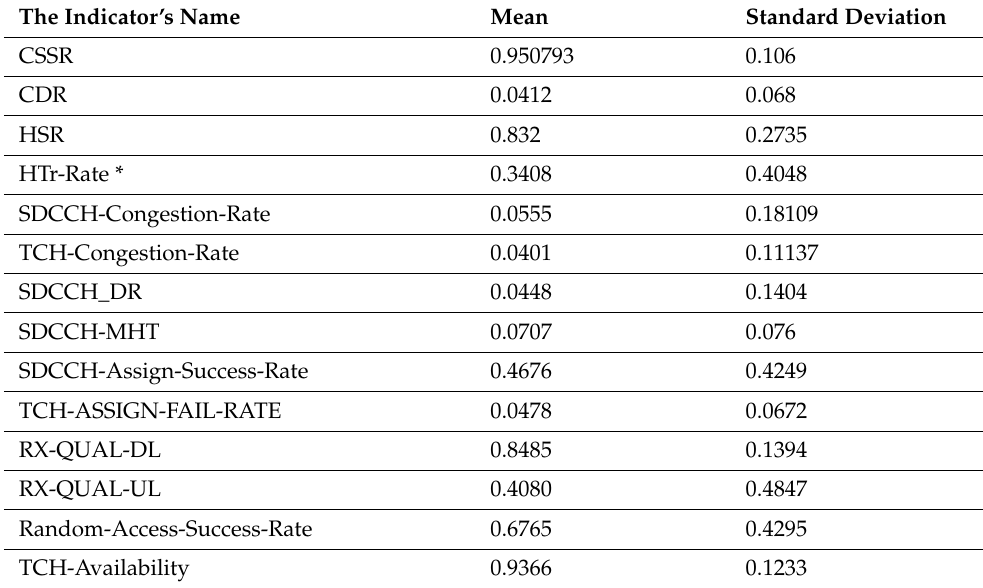
Table 2. Statistical status of the used